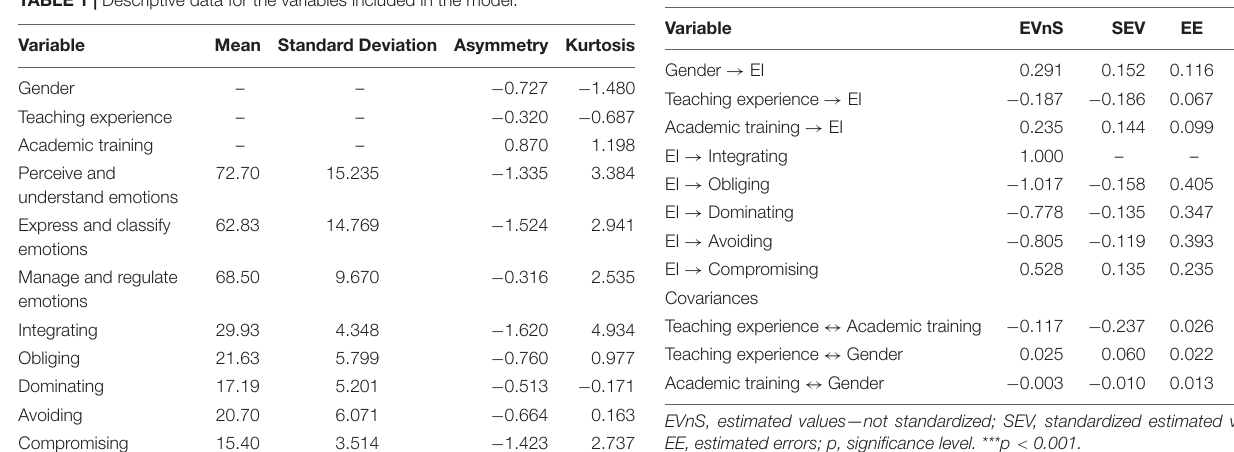
TABLE 2 | Results of covariance